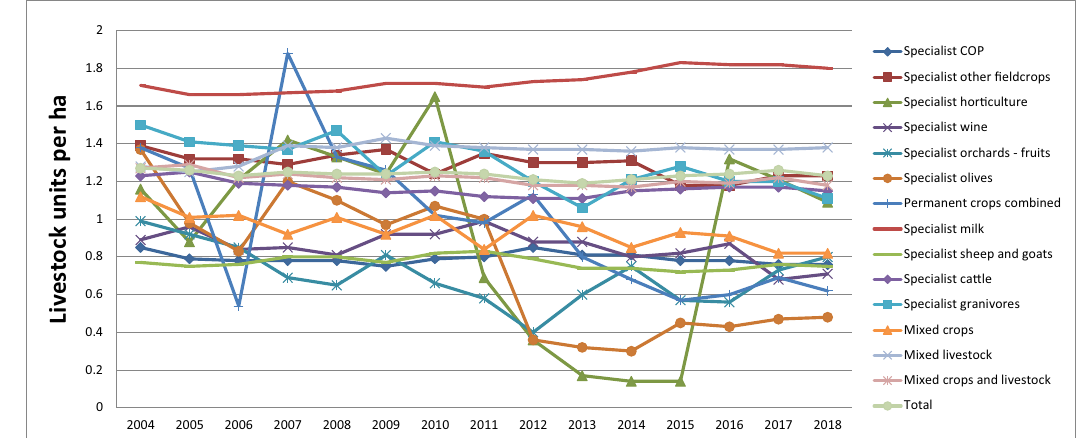
Figure 4: Stocking density, per farm, for several farm types, for the period 2004 –